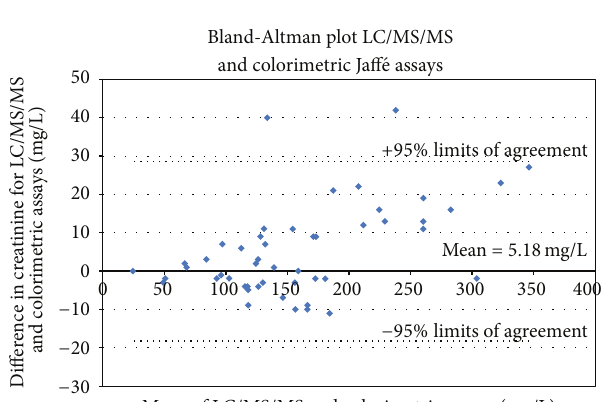
Figure 2: Bland-Altman plot comparing the LC/MS/MS and Jaff´e reaction methods for 50 urine samples.